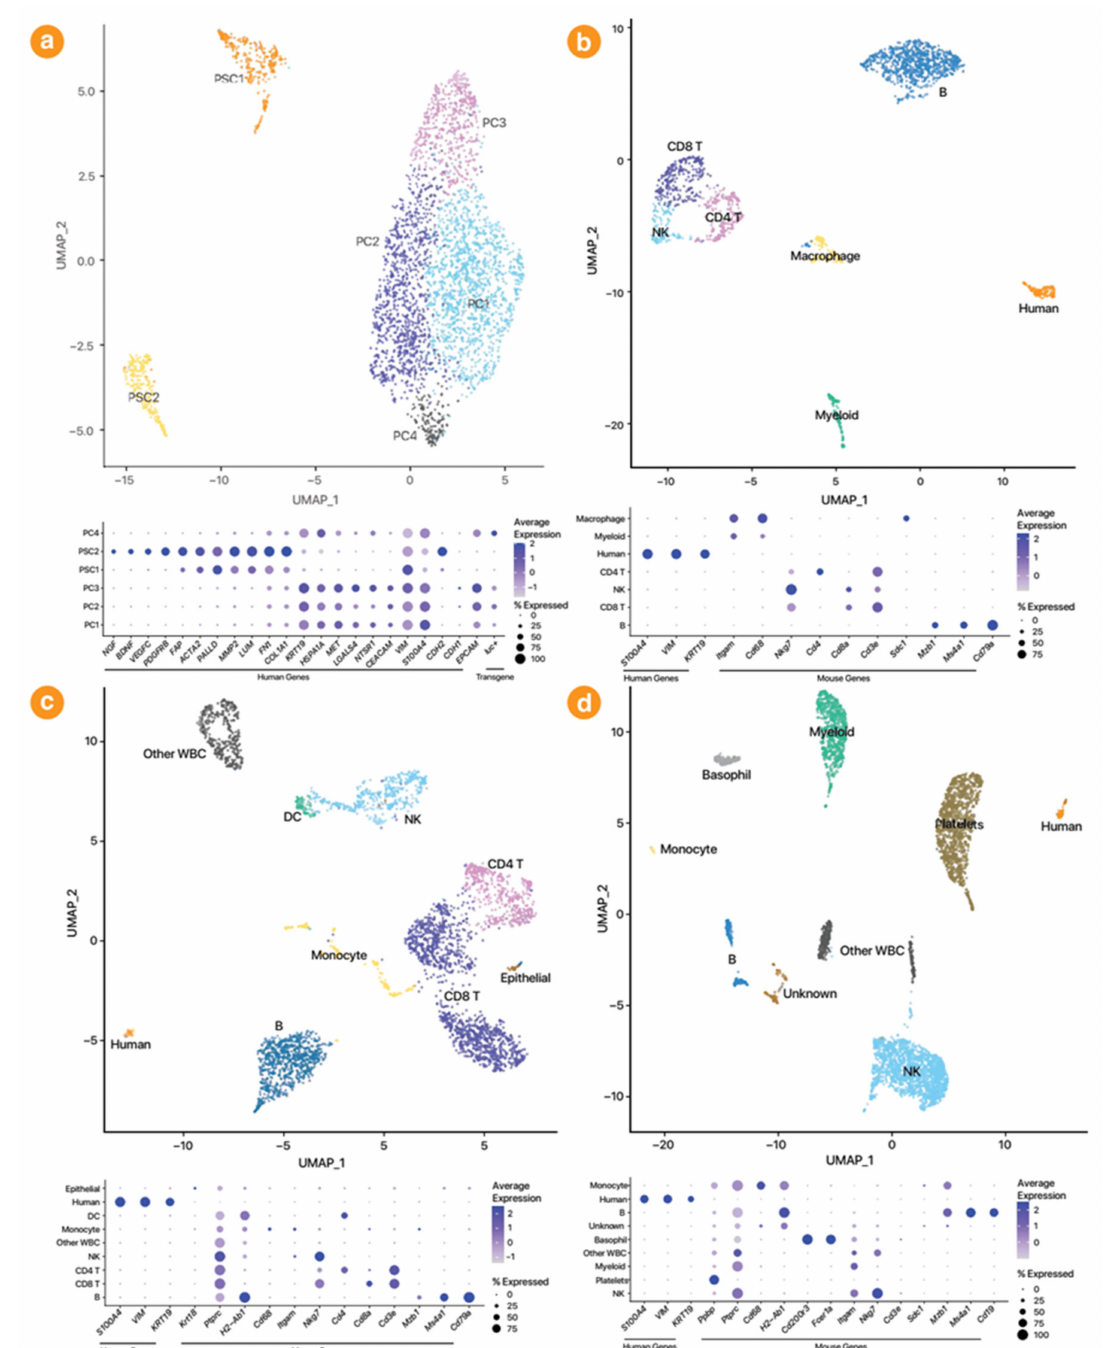
Figure A9. Cell Clustering and Identification. ( a ) UMAP and dot plots of cells from the mouse blood sample (MsBlood), demonstrating clustering into two major cell types (PSCs and PC cells) and illustrating canonical marker expression of these cell subgroups. Luciferase ( luc+ ) was expressed in some PC cells but not in PSCs, as expected. ( b – d ) UMAP and dot plots, demonstrating clustering into different cell types and relative canonical marker expression. Cells which expressed the leucocyte marker Ptprc (CD45) without classical leucocyte subtype expression profile were classified as “Other WBC”. The specimens are: ( b ) mouse primary tumour sample (MsPrim); ( c ) mouse model metastatic tumour sample (MsSec); ( d ) mouse model blood sample (MsBlood). Abbreviations: B, B lymphocytes. DC, dendritic cells. NK, natural killer cells. T, T lymphocytes (CD4+ or CD8+). WBC, white blood